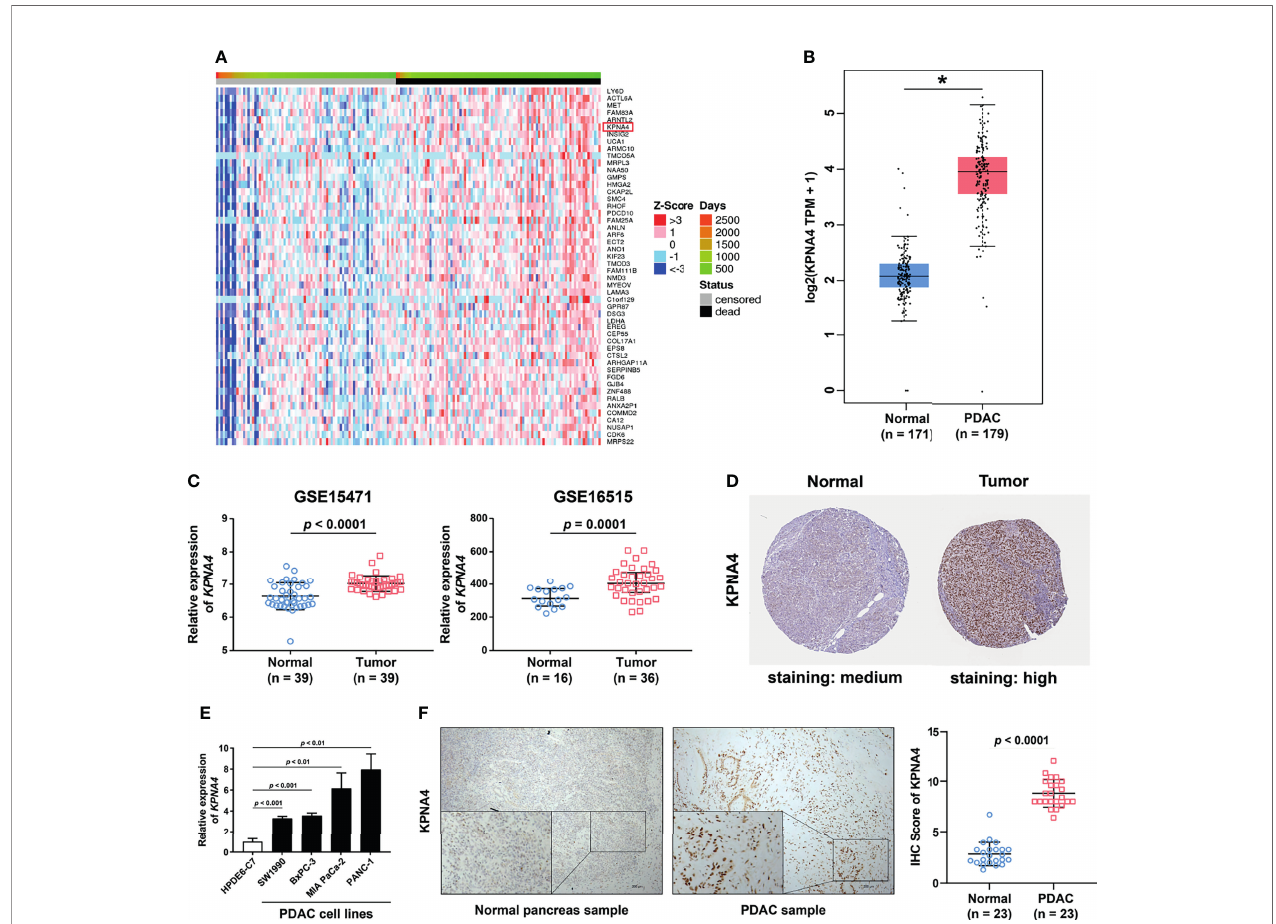
FIGURE 1 | High expression of KPNA4 in PDAC. Heatmap of 50 genes which were most signi fi cantly positively associated with unfavorable survival in PDAC patients (A) . The mRNA expression of KPNA4 was found to be signi fi cantly upregulated in PDAC tissues by using GEPIA (B) and GEO databases (C) . The protein level of KPNA4 was also remarkably increased in PDAC tissue by immunohistochemical images from the HPA database (D) . The upregulation of KPNA4 in PDAC was veri fi ed in cell lines by qRT-PCR analysis (E) . The protein expression level of KPNA4 was validated in clinical samples by immunohistochemical staining. Scatter plot indicated the histochemistry score of KPNA4 in PDAC and matched normal tissues (F) . p -value < 0.05 was regarded statistically signi fi cant. * p <